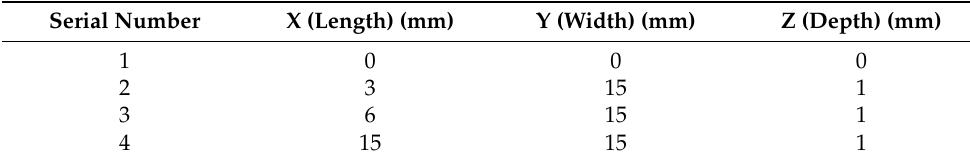
Table 4. Parameter setting of bearing outer ring wear amounts.